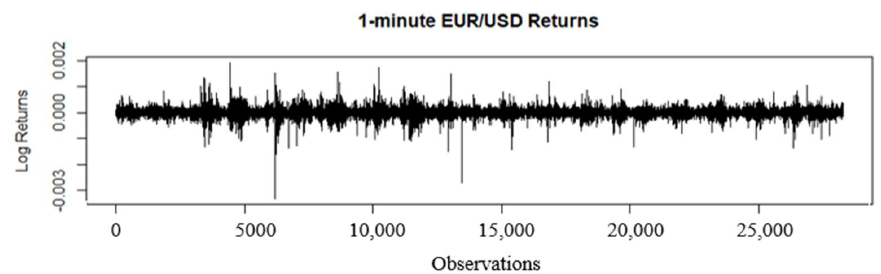
Figure 1. Return series plot for the 1-min EUR/USD exchange rate returns. Risks 2019 , 7 FOR PEER REVIEW